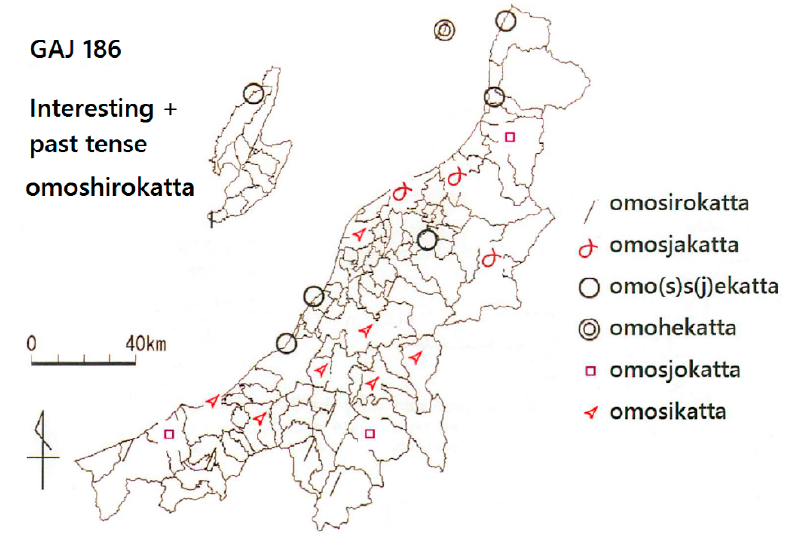
Figure 13. Map of omoshirokatta “interesting” + past tense: GAJ data.